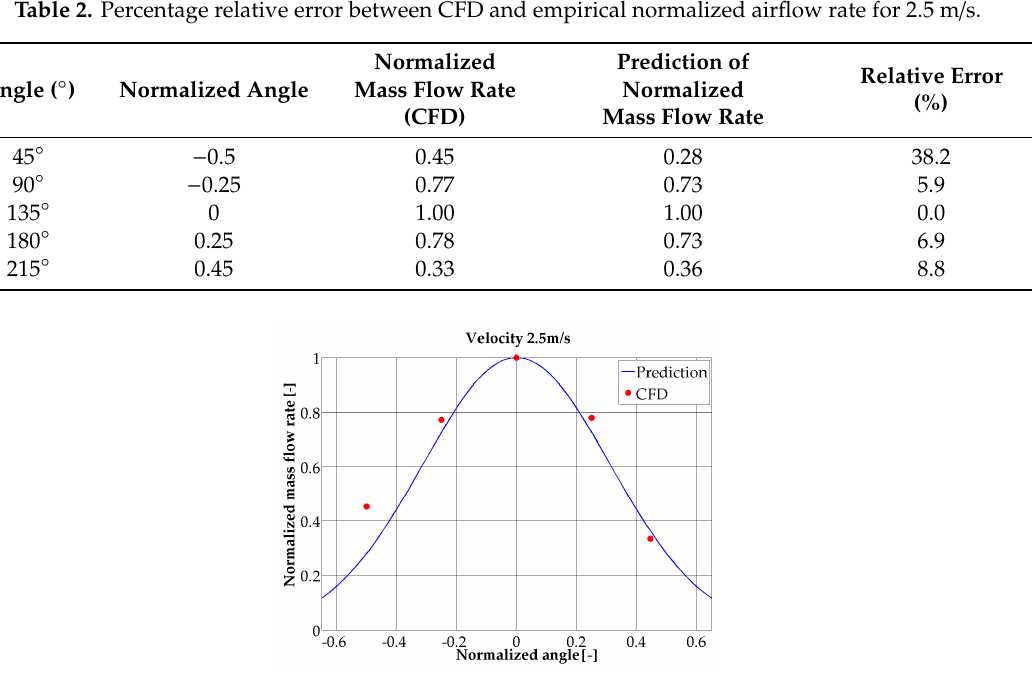
Figure 18. Comparison of normalized mass flow rate between CFD results and values derived by the function for 2.5 m/s wind speed.